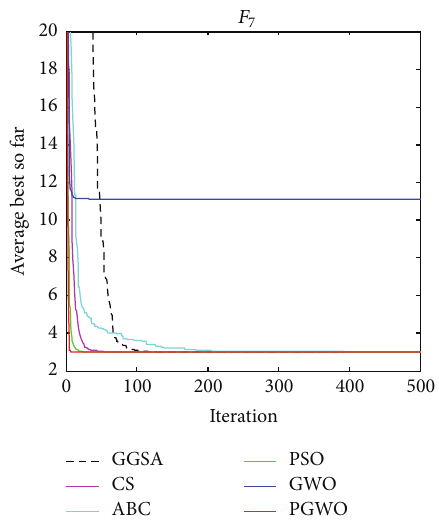
Figure 1: The convergence curves of the average fitness value over 20 independent